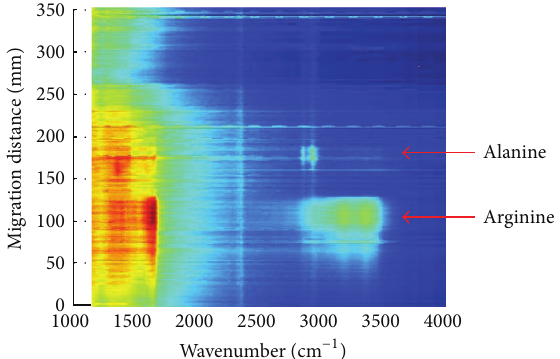
Figure 3: 3D chromatograph to locate the arginine spot on a narrow band TLC plate.